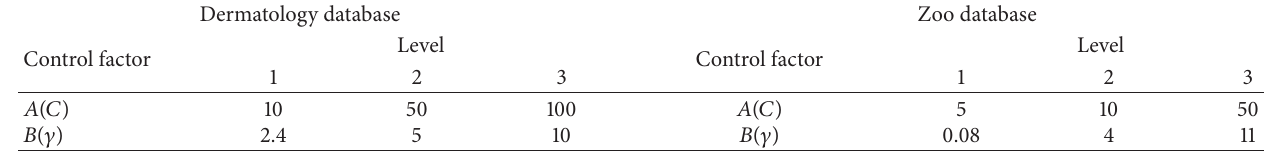
Table 5: Factor level configuration of LS-SVM parameter